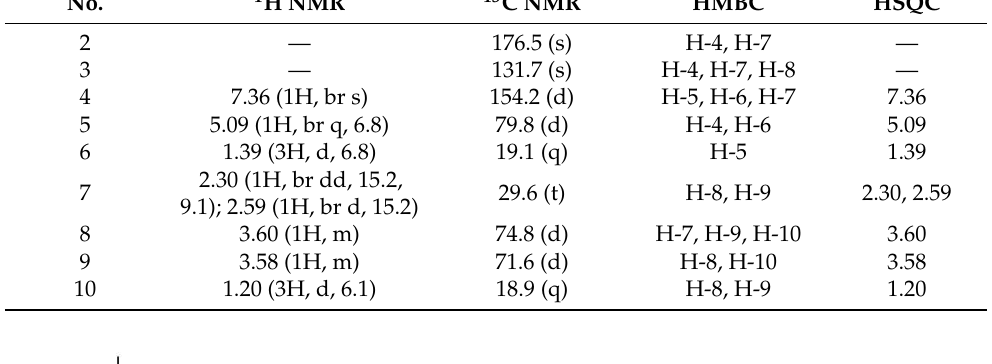
Figure 2. Signal assignments of compound 4 via 13 C and 2D NMR.